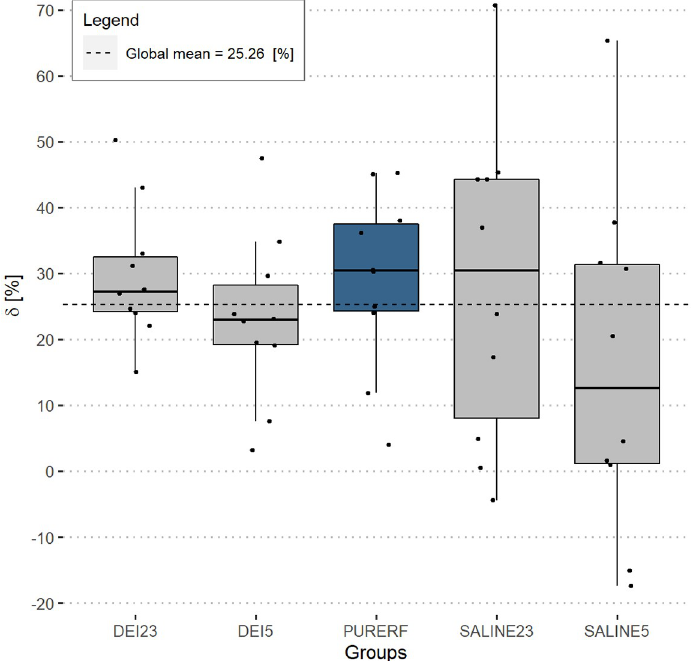
Fig 5. Performance index δ . The positive sign of δ indicates two findings: 1—the curve is asymmetric, the procedure midpoint is not the minimum impedance point; and 2—the minimum impedance point is ahead of the RFA operating midpoint. In only two cases did the minimum impedance point occur before the half of experiment time (in the SALINE5 group).